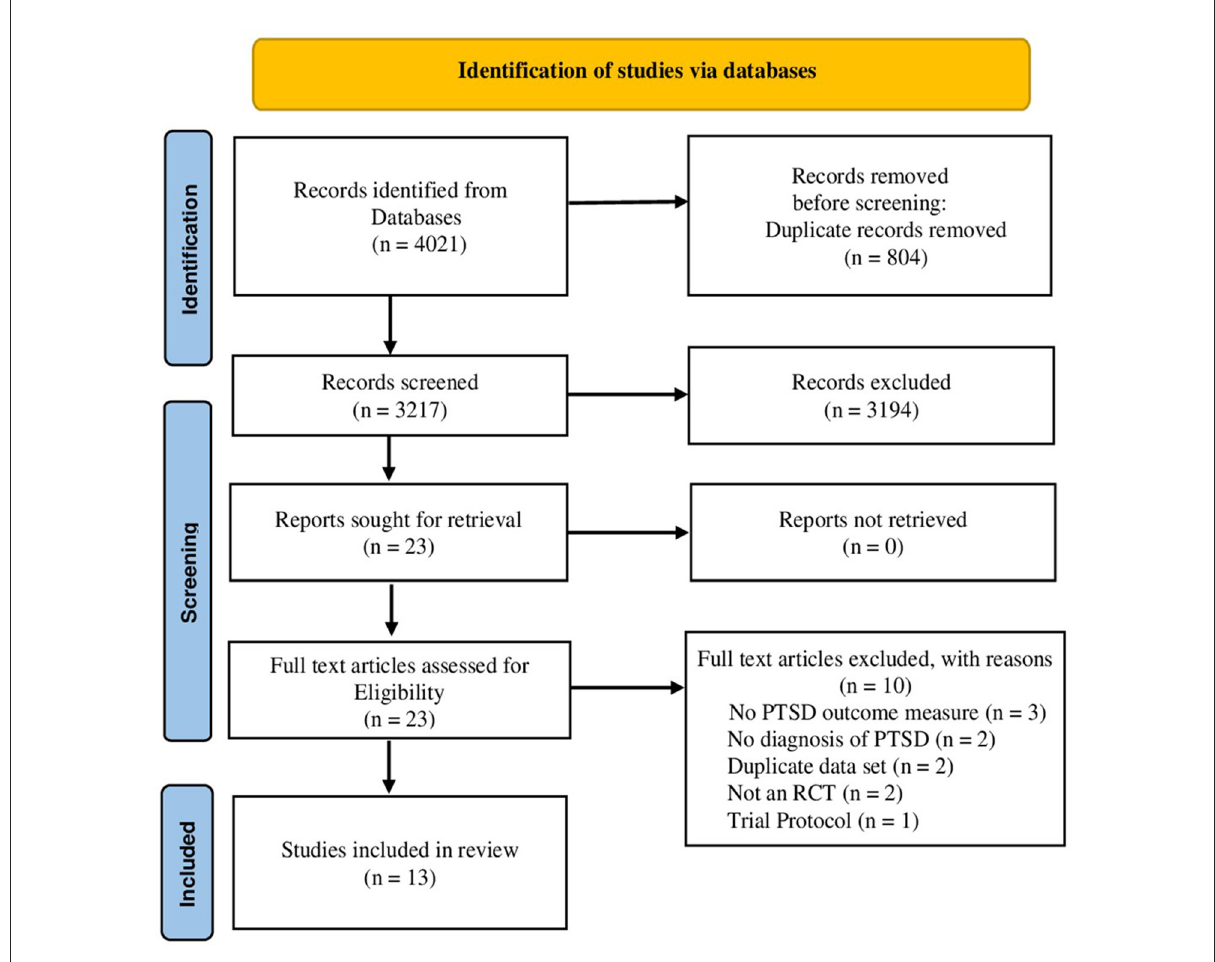
FIGURE1 PRISMA Flowchart of the study selection